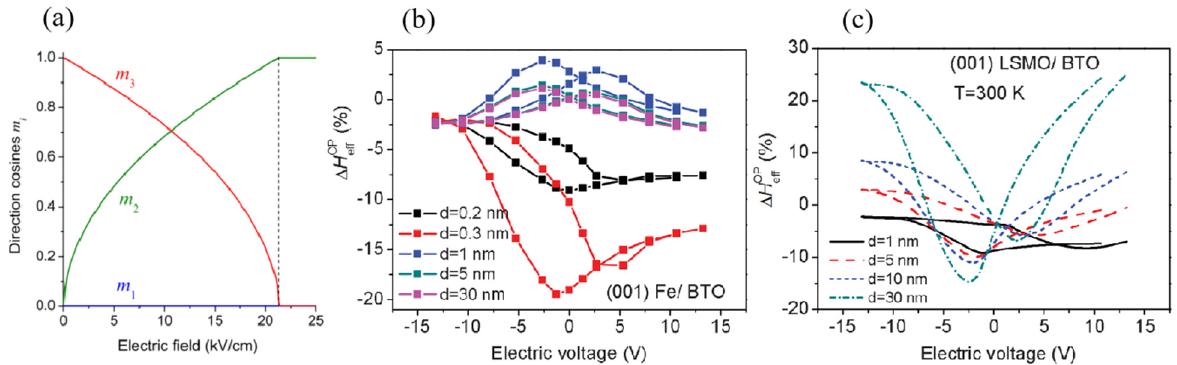
Figure 3. Calculation of voltage-induced changes in magnetic anisotropy. ( a ) Electric field rotates the direction of magnetic easy axis 90° in the Ni layer. Calculation combining both strain and electronic effects via the electric field dependence of out-of-plane anisotropy field for Fe/BTO heterostructure ( b ), and LSMO/BTO heterostructure ( c ). Reproduced with permission from reference [49,51].